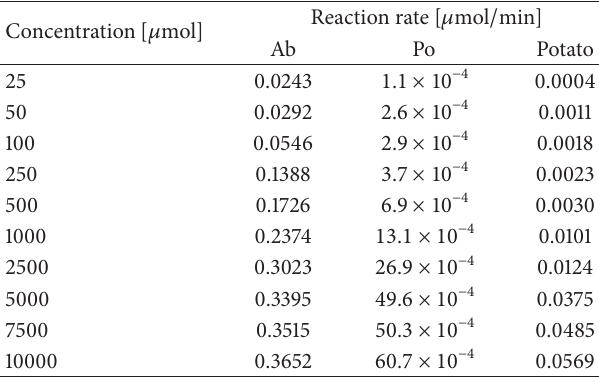
Table 2: Input experimental kinetic data